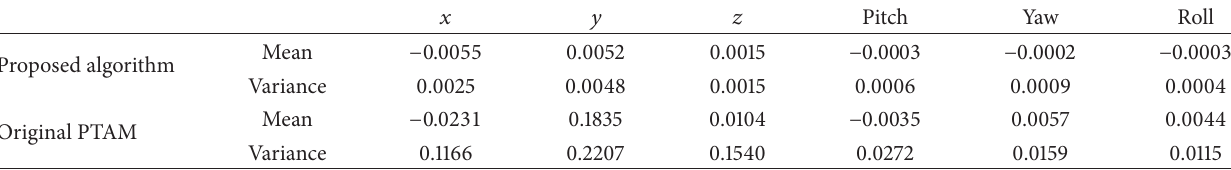
Table 1: The deviation evaluation of original PTAM and proposed algorithm to ground only